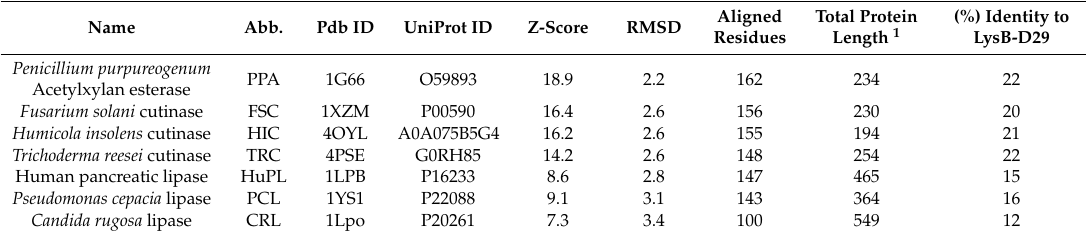
Table 1. Relative members of α / β hydrolase family used in multiple sequence alignment and structural